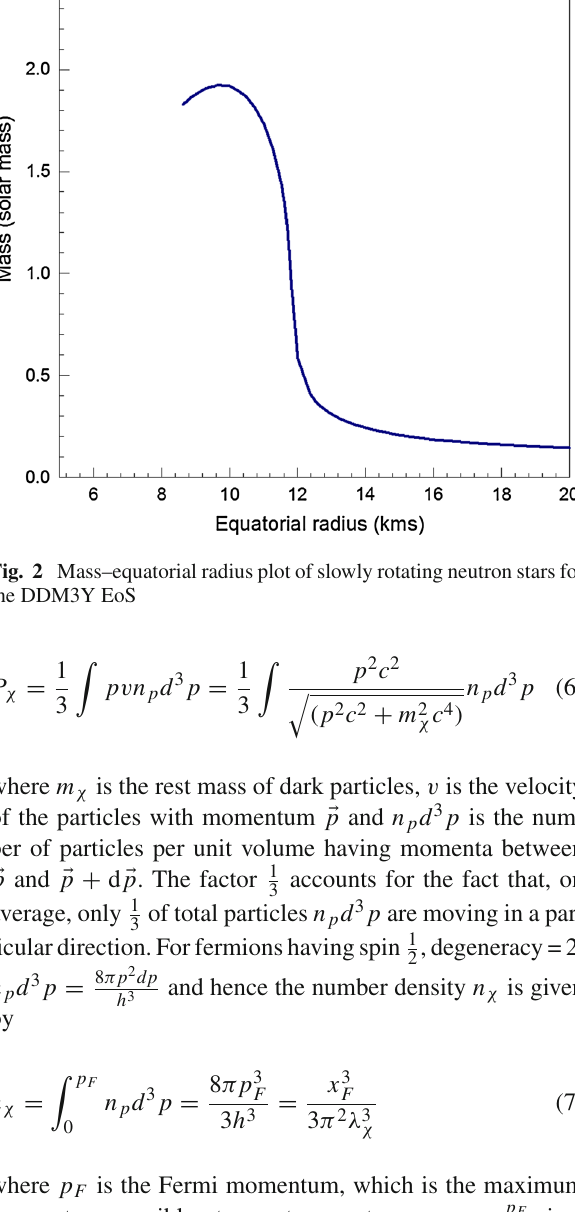
of symmetric nuclear 3